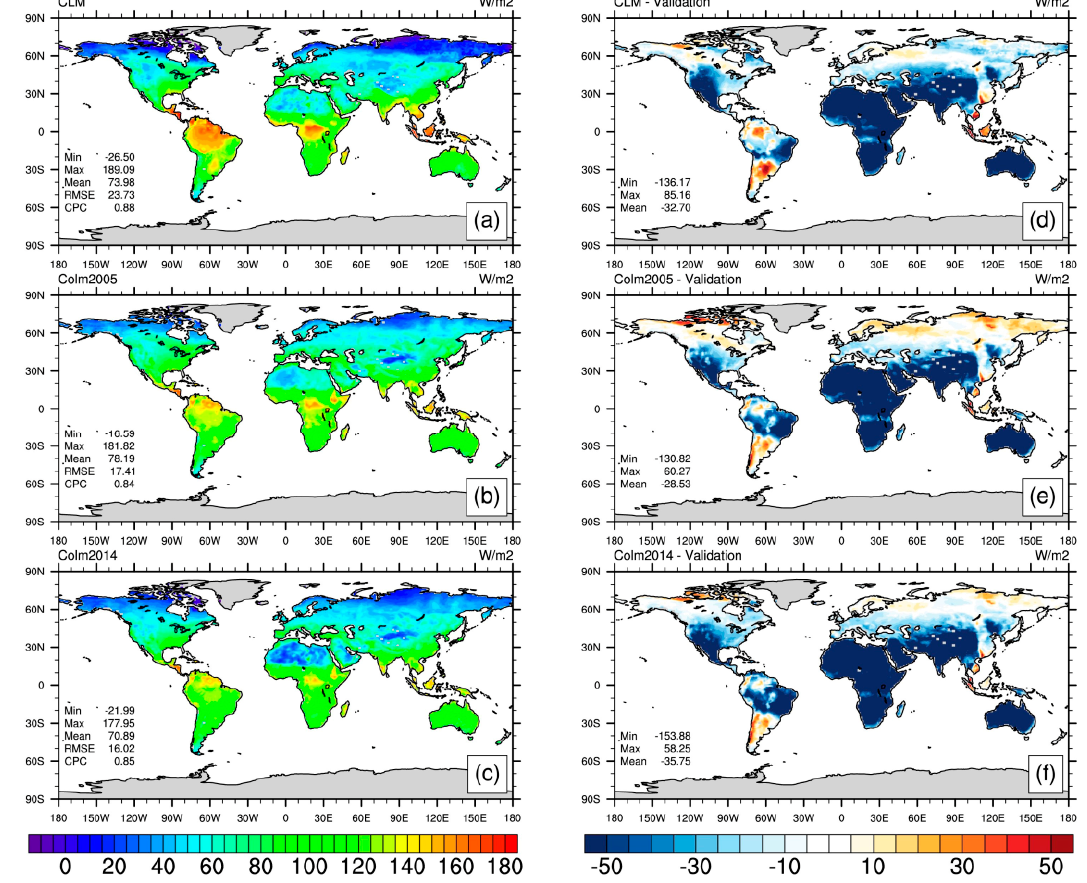
Figure 19. Annual mean spatial distributions of net radiation simulated by ( a ) CLM4.5; ( b ) CoLM2005; and ( c ) CoLM2014; Along with spatial distributions of biases relative to the validation standard for ( d ) CLM4.5; ( e ) CoLM2005; and ( f ) CoLM2014 (Units: W m − 2 ).